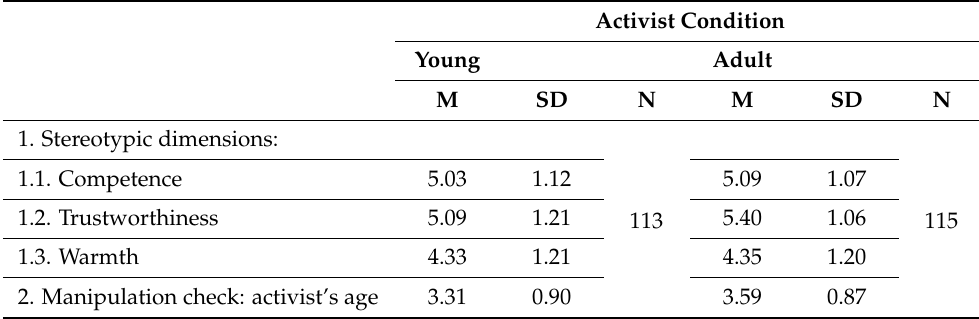
Table 2. Descriptive statistics by experimental condition.